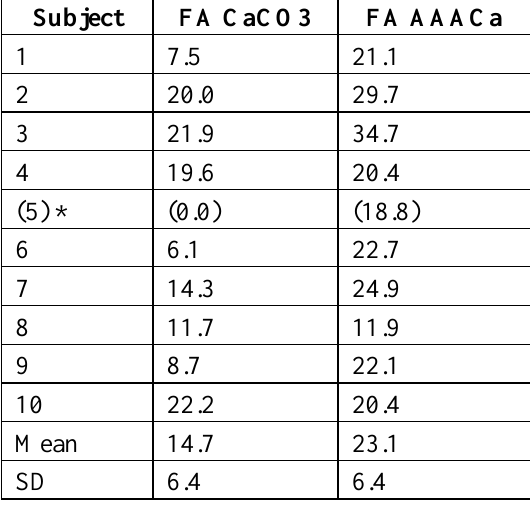
Table 4. Fractional absorption (FA) of CaCO3 and AAACa by dual stable isotope